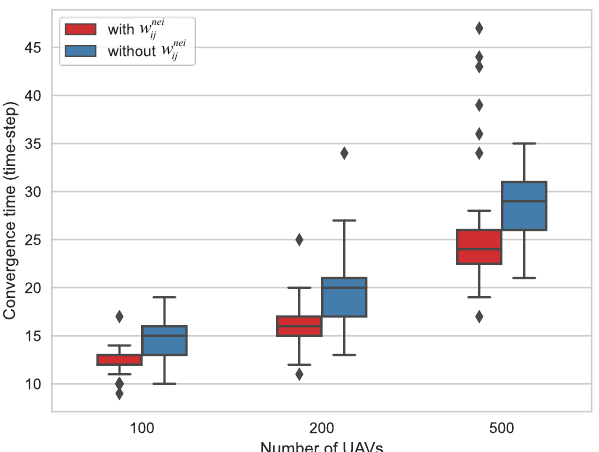
Figure 6. The box-plot for system performance under different application circumstances of the neighborhood layer status. The red boxes represent the system performance with the mechanism of weighting the neighborhood layer and the blue boxes without. The black rhombus are the extreme